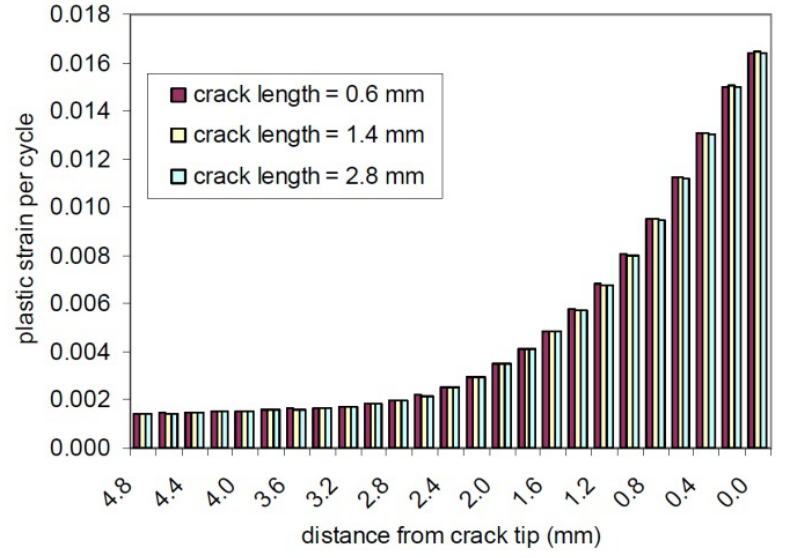
Figure 1. Crack tip distance and accumulated plastic strain per cycle